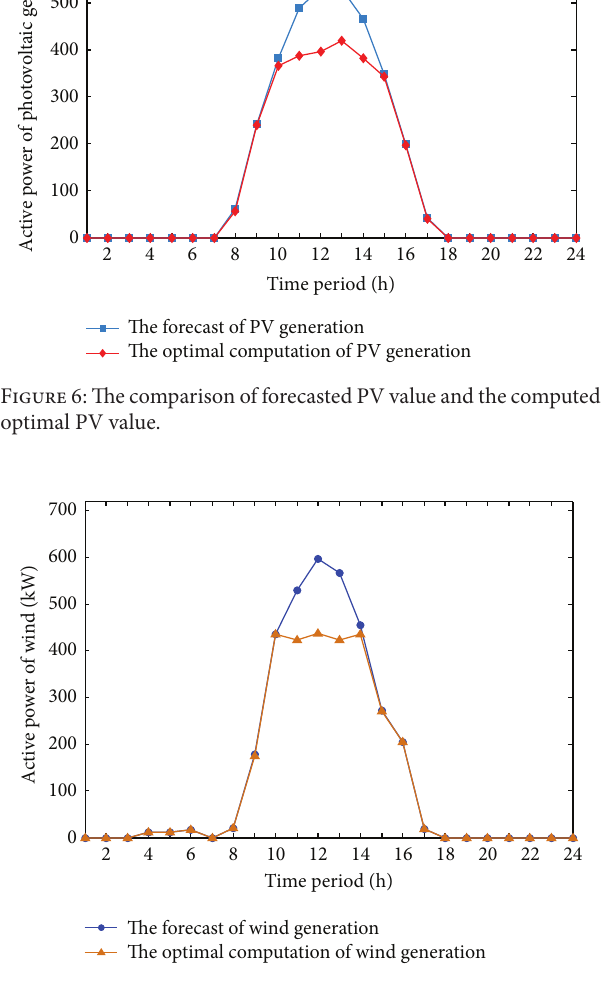
Figure 7: The comparison of forecasted wind values and the computed optimal value.